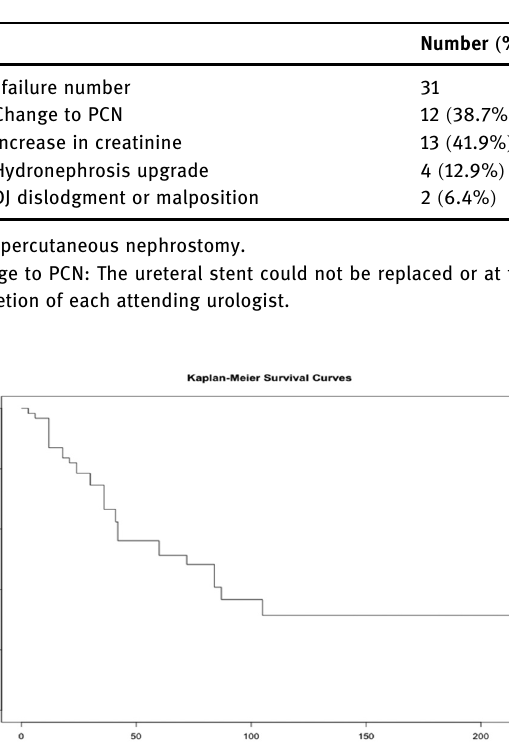
Table 3: Univariate analysis of DJ failure